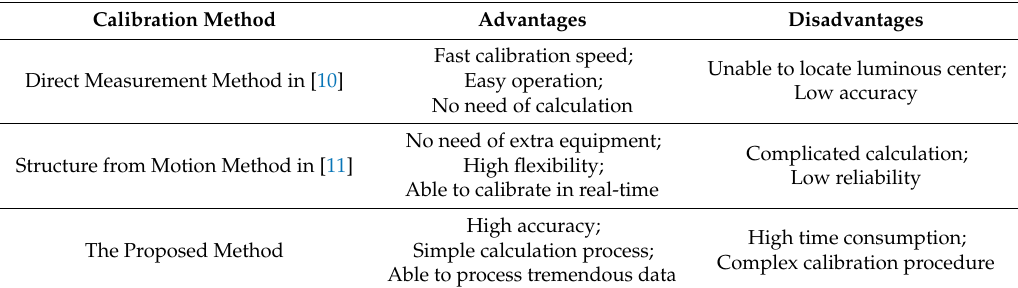
Table 1. Comparison table of the pros and cons of calibration methods.